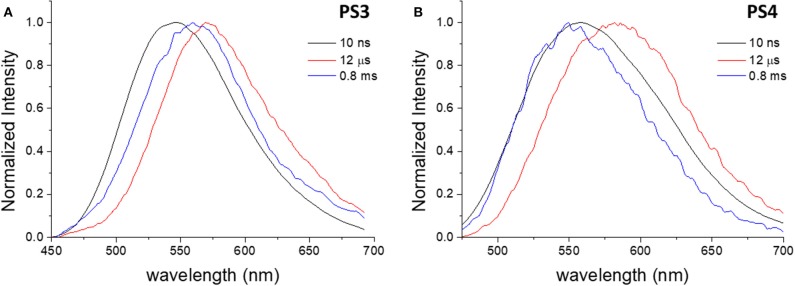
Normalized time-resolved emission spectra of PS3 (A) and PS4 (B) in degassed aqueous suspension, collected at different delay times. λex = 355 nm.